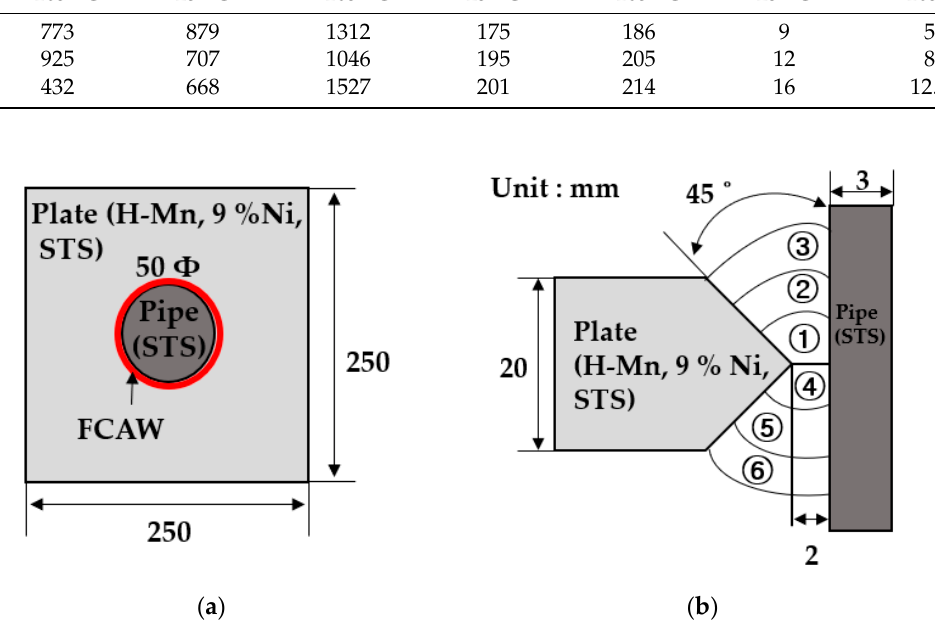
Figure 1. Test specimen dimensions and groove shape: ( a ) configuration of the test specimen; ( b ) groove shape. Table 1. Chemical compositions of the cryogenic steels.